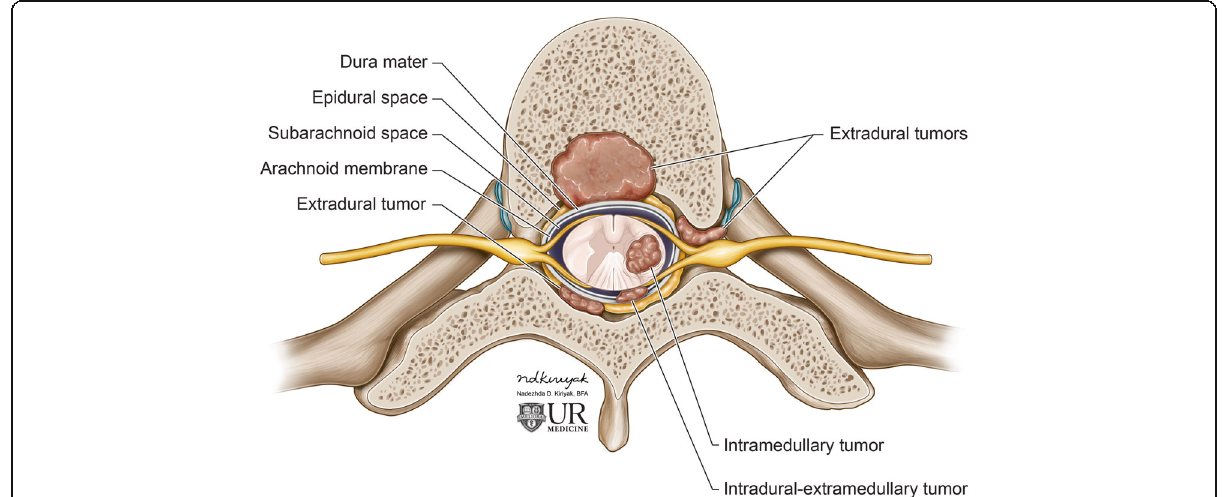
Fig. 1 Classification of spinal tumors by location. Spinal neoplasms can be classified according to their anatomic locations, specifically extradural, extramedullary-intradural, and intramedullary